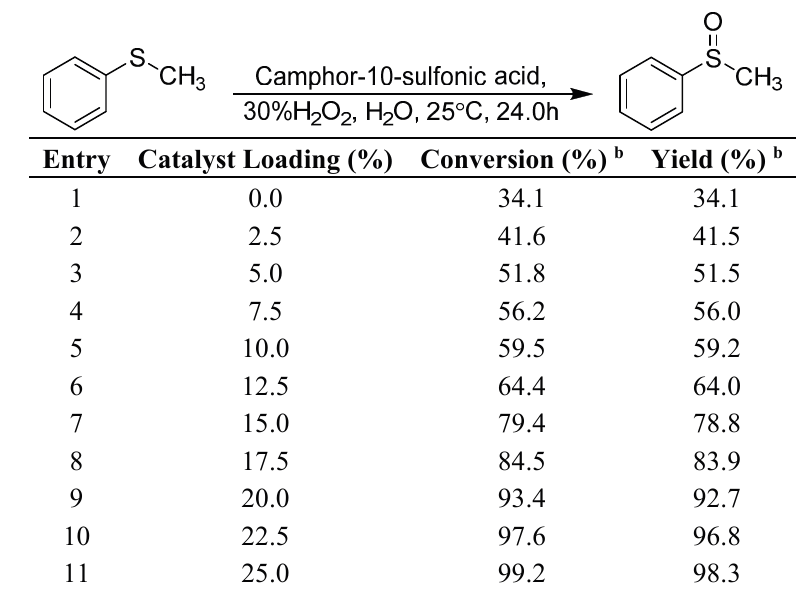
Table 1. Effect of catalyst loading on the oxidation of methyl phenyl sulfide with H 2 O 2 catalyzed by camphor-10-sulfonic acid a .